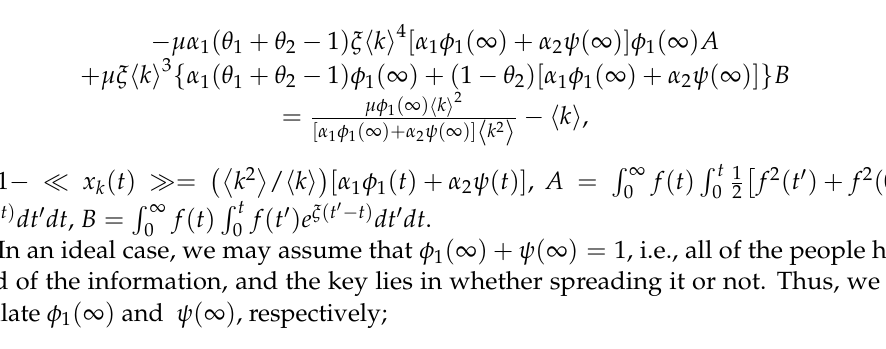
Figure 6. ( a ) The time series for spreaders with different degree ( 𝒌 ) in 𝓡 time series for the densities of spreaders and stiflers with 𝓡